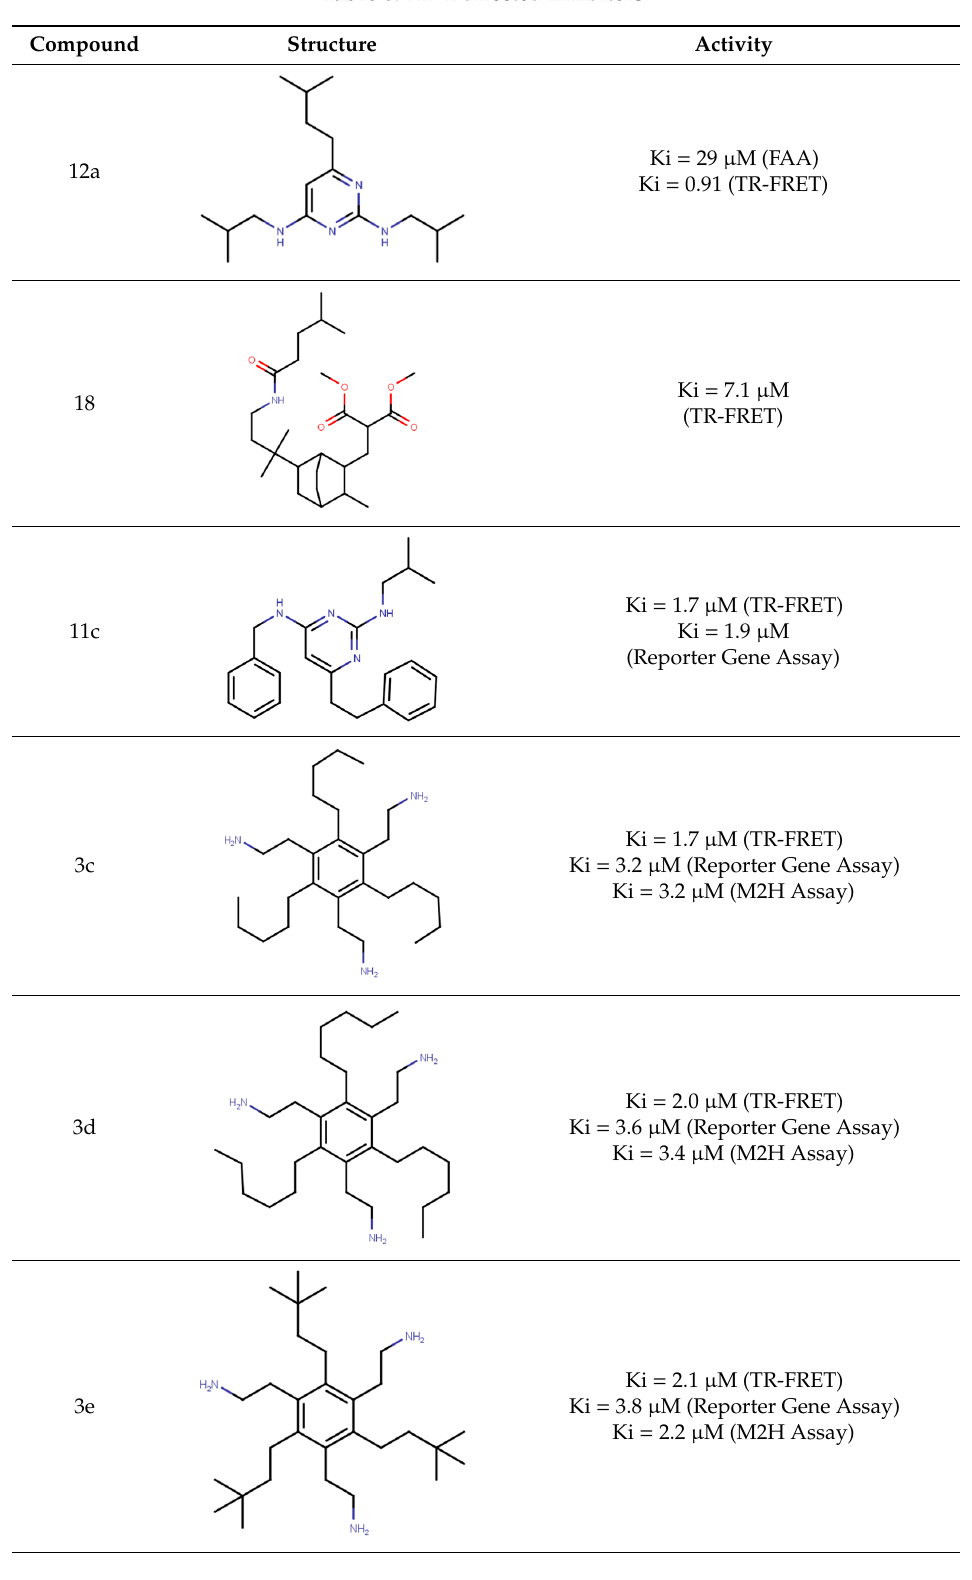
Table 6. AF-2 directed inhibitors.